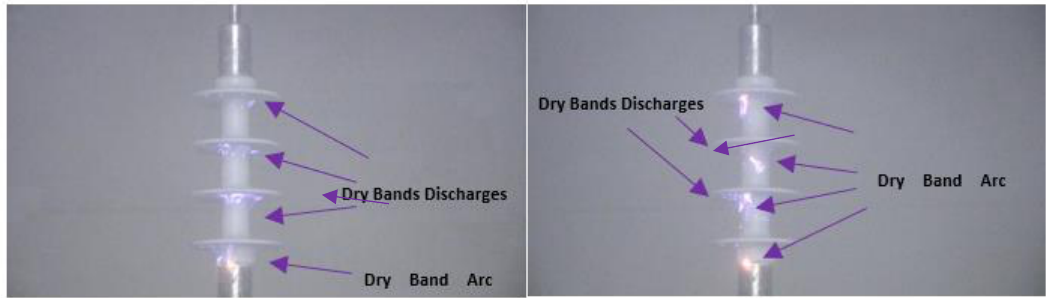
Figure 8. Visual observation of DbDs and DBAs activity with ESDD 1 = 0.12 mg/cm 2 and NSDD 2 = 0.11 mg/cm 2 .